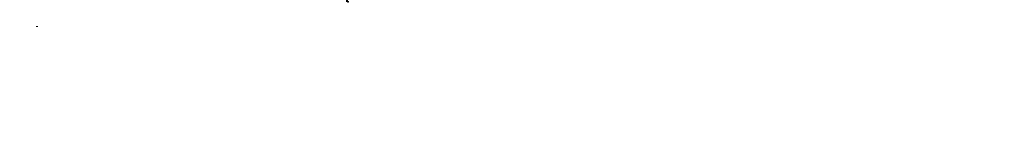
Logopediese Vereniging, Vol. 17, Nr. : Des.